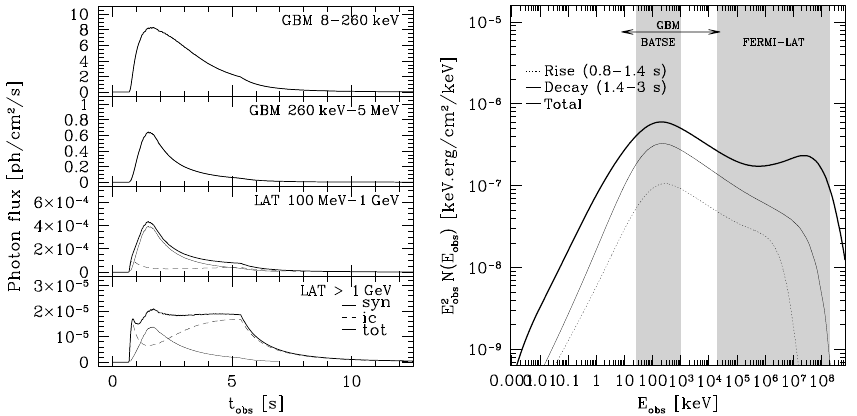
Fig.15. A single pulse burst in the “synchrotron case” with a low magnetic field. Same as in Fig. 14 except for the microphysics parameters: Figure 1. A single pulse burst: the main emission peak is due to the synchrotron radiation. The ! B = 5 microphysics parameters used in the simulations are (cid:101) B = 5 × 10 − 3 , (cid:101) e = 1/3, ζ = 2 × 10 − 3 , p = 2.5, and dE/dt = 5 × 10 53 erg s − 1 . As the assumed magnetic field is low, the non-negligible signatures of in- verse Compton scatterings are favored in the Fermi LAT (the Large Area Telescope) energy range LAT energy range. The process included in calculation are the following: adiabatic cooling, synchrotron emission and synchrotron-self absorption, inverse Compton scatterings, and γγ -annihilation. The effects of secondary pairs were not taken into account. Left : observed light curves in Fermi -GBM (Gamma-ray Burst Monitor and the LAT range. The synchrotron (thin solid line) and inverse Comp- ton (thin dashed line) components are shown. Right : observed time-integrated spectrum during the rise, early decay, and whole duration of the pulse. From Credit: [131], reproduced with permission ©ESO